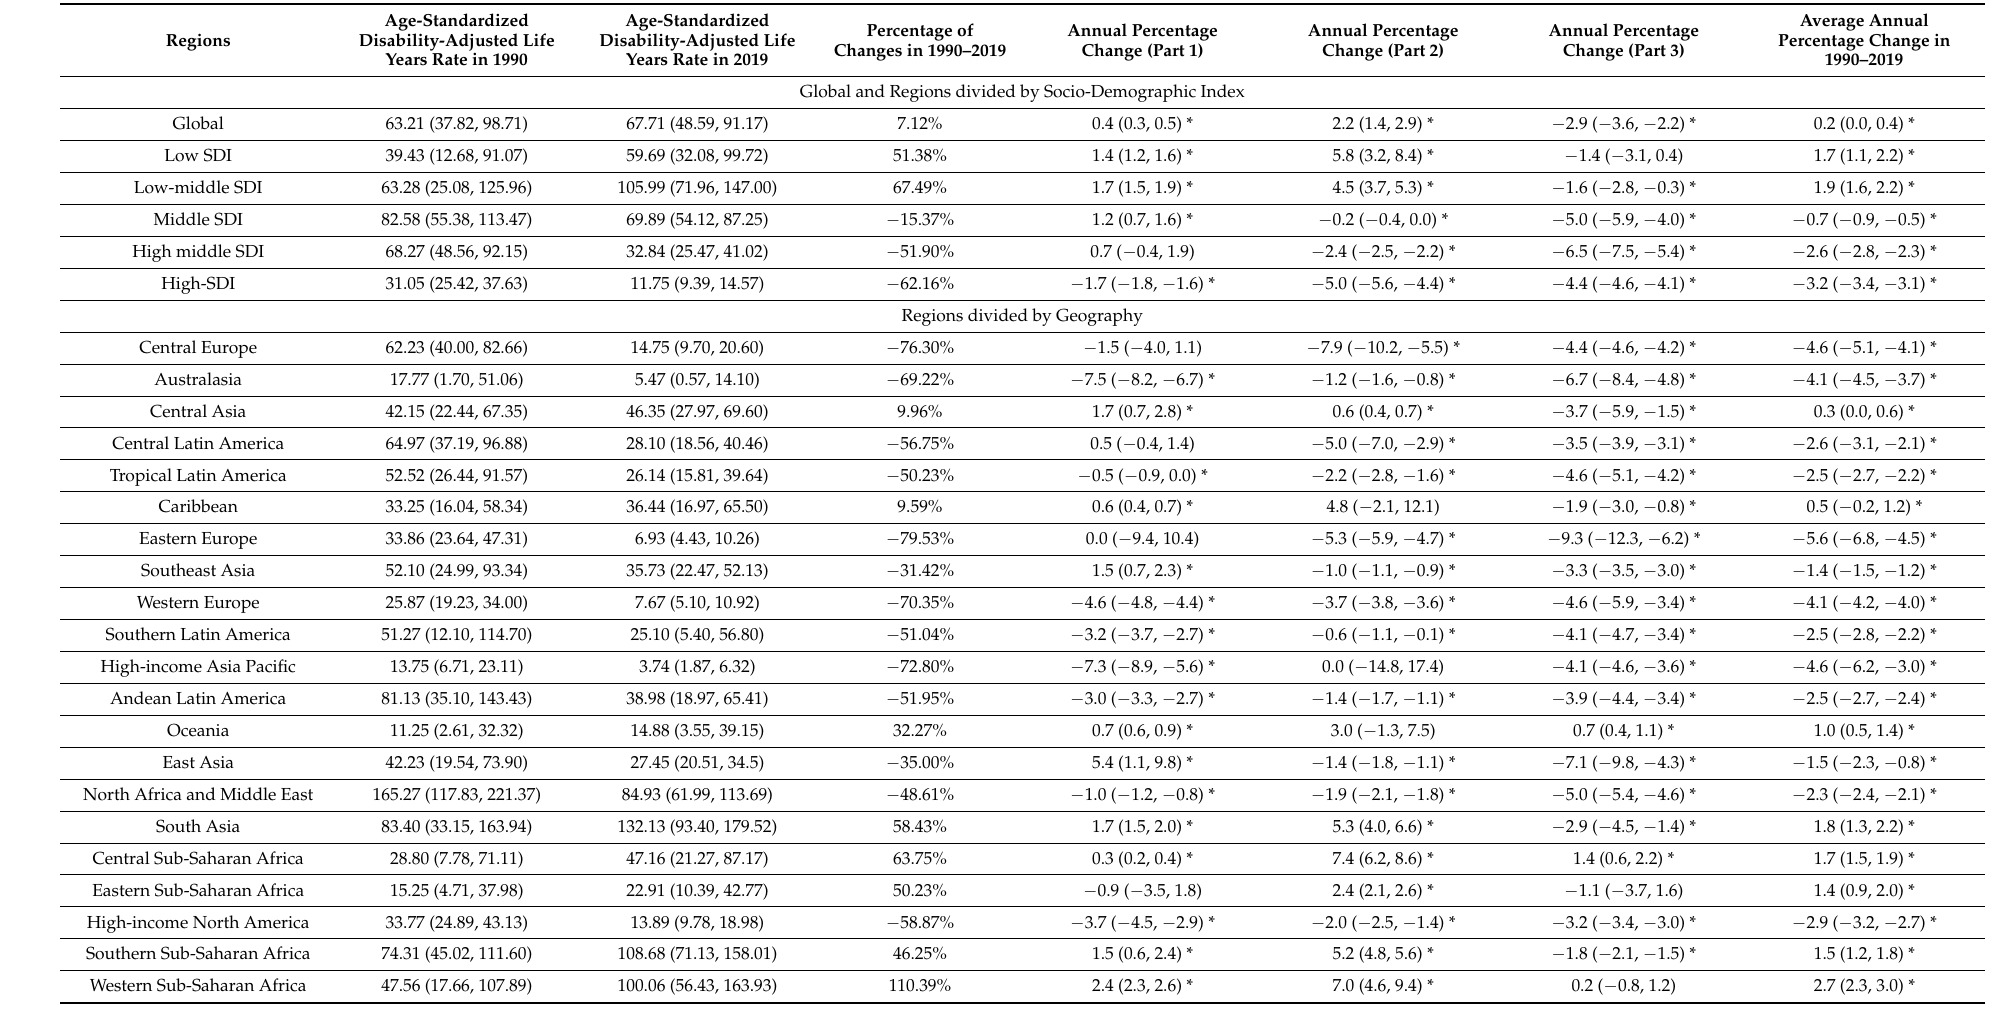
Table 2. Age-standardized disability-adjusted life years rate in PM 2.5 -related preterm birth: rate, percentage of changes, annual percentage changes, and average annual percentage changes in the global and different regions in